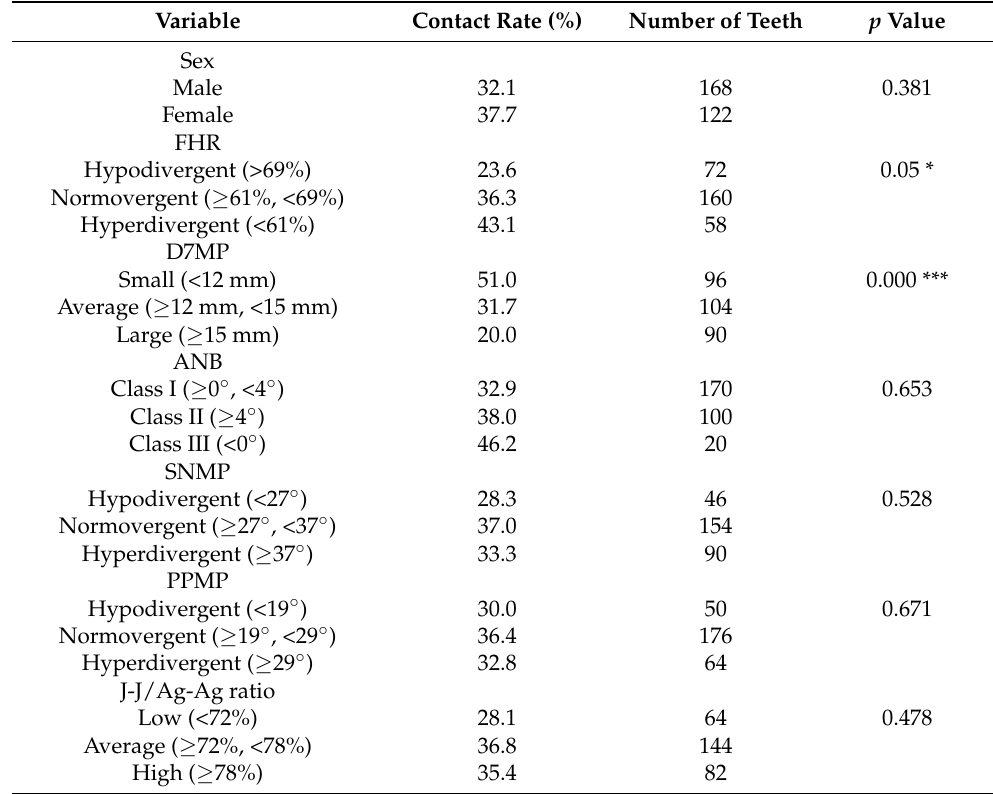
Table 6. Comparison of contact rate between the mandibular second molars and lingual cortical bone according to the clinical